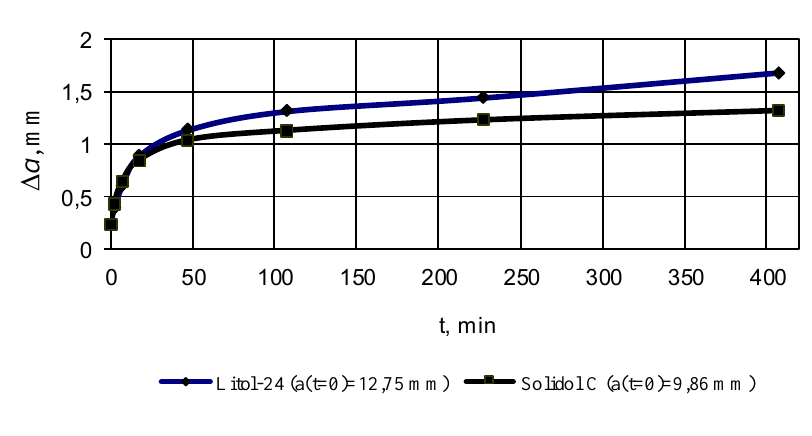
Fig. 3. The results of pressing the ball into the oil